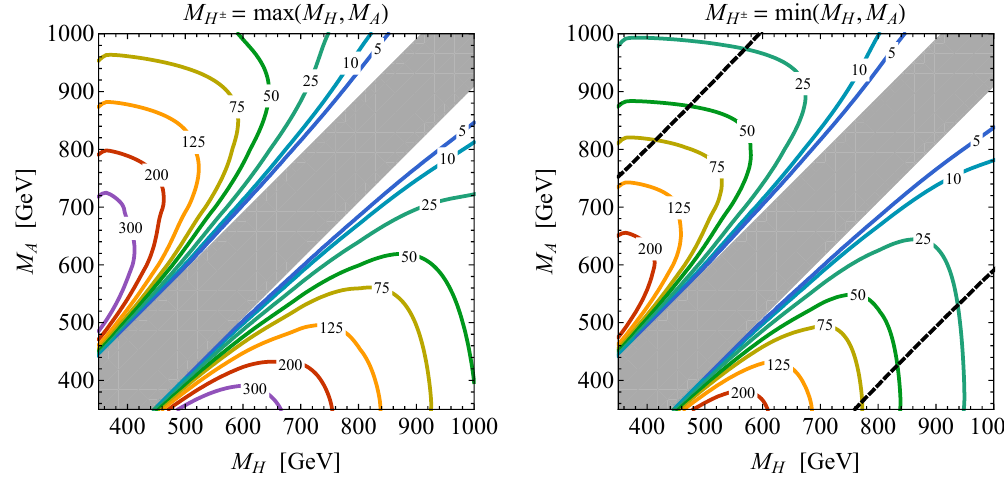
Figure 3 . Approximate signal strengths for pp ! t (cid:22) tZ production in units of fb. The left (right) (cid:0) plot is obtained by (cid:12)xing the charged Higgs mass to M = max ( M H ; M A ) M = H (cid:6) H (cid:6) p (cid:1) min ( M H ; M A ) in the scan. Both panels correspond to the type-II 2HDM and employ s = 14 TeV, c (cid:12) (cid:0) (cid:11) = 0 and t (cid:12) = 1. The grey bands indicate the values of M H and M A that are kinematically inaccessible in pp ! H=A ! A=HZ ! t (cid:22) tZ . In the upper left and lower right corner of the right panel the total decay widths of the Higgses become sizeable. The dashed black lines correspond to the contour max ((cid:0) H =M H ; (cid:0) A =M A ; (cid:0) =M ) = 30%. H (cid:6) H (cid:6)